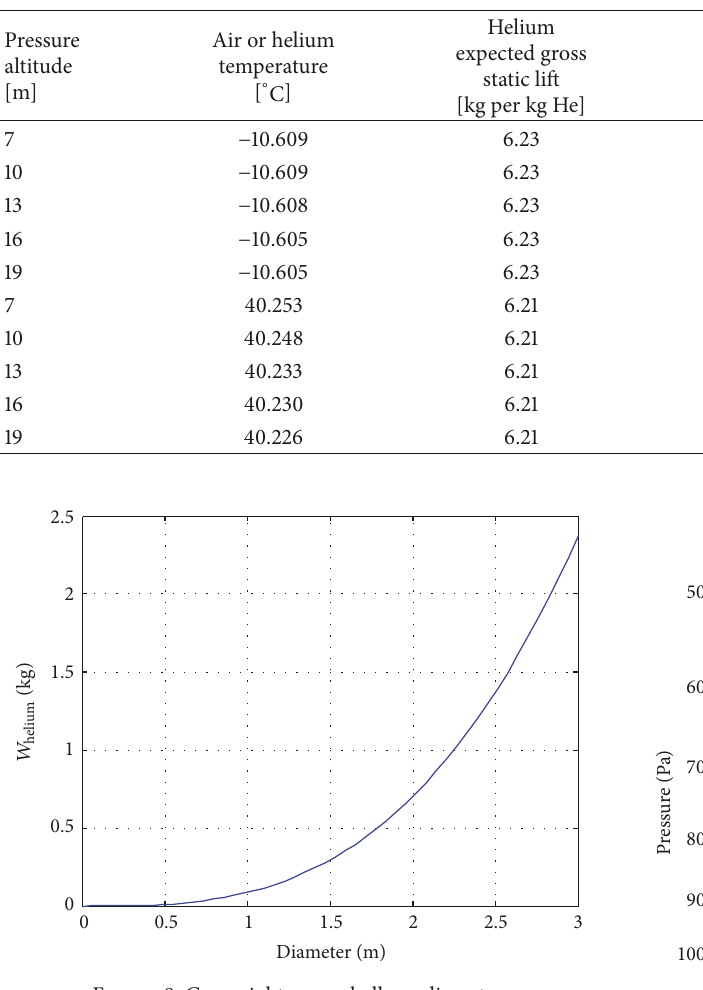
Figure 9: Gas weight versus balloon diameter.